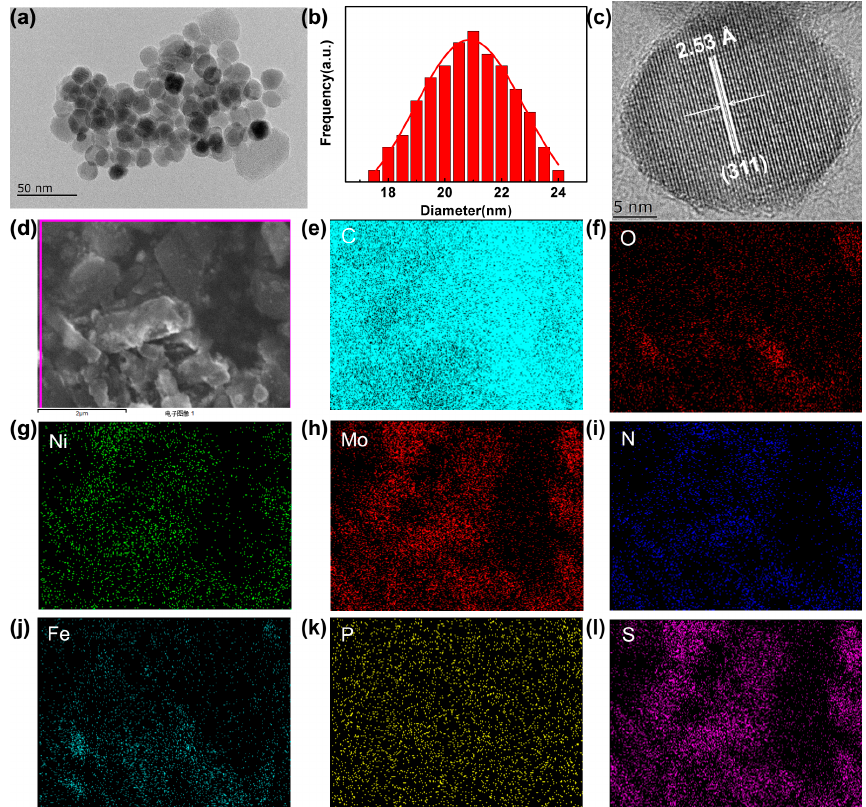
Figure 6. ( a ) TEM image, ( b ) particle size histogram, ( c ) HRTEM image, ( d ) STEM image and ( e – l ) corresponding elemental mappings of Fe 3 O 4 @ 1 .